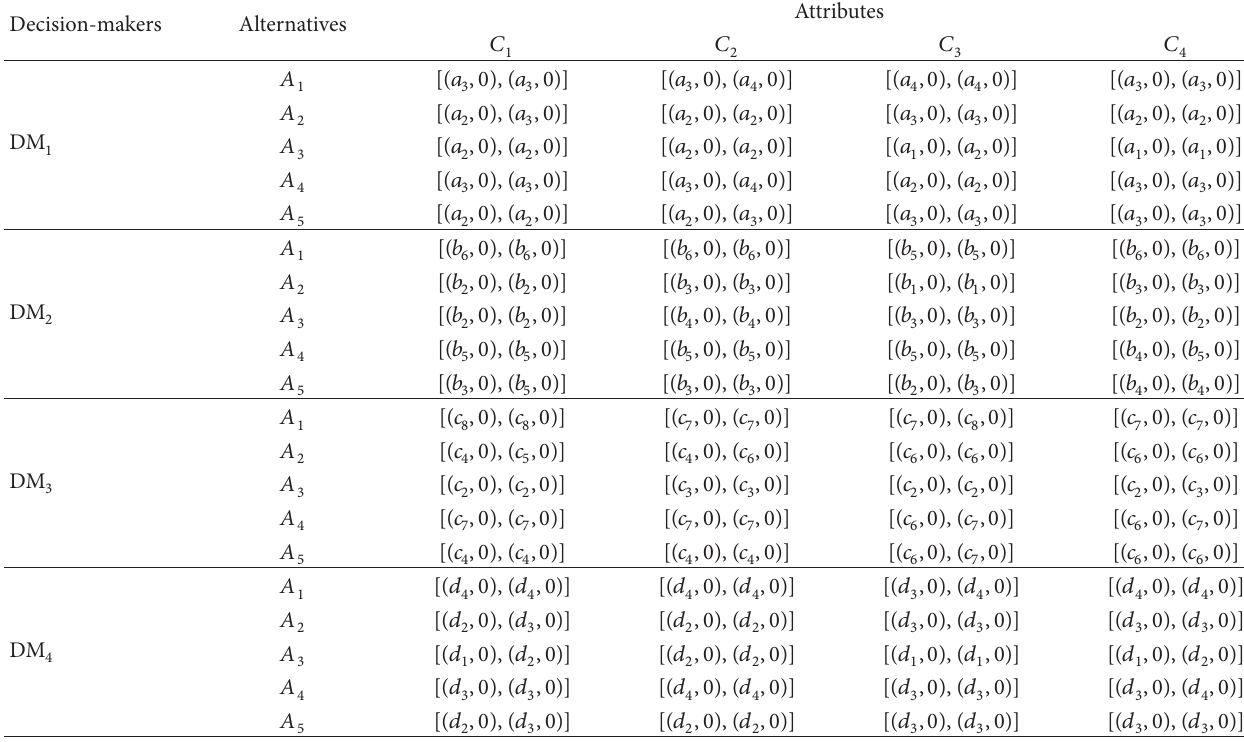
Table 2: Interval 2-tuple linguistic decision matrix of the four decision